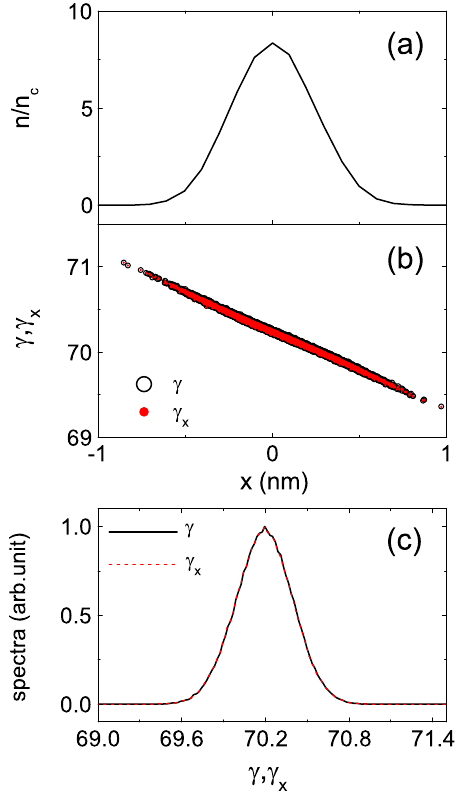
FIG. 2. PIC results for a laser-driven RES obtained for the configuration of Fig. 1: (a) electron density profile; (b) (cid:1) and (cid:1) x plotted versus propagation direction x ; (c) electron energy spec- trum. The results correspond to Fig. 1(c), i.e., to the time when the RES has just emerged from the reflector foil. Simulation parameters are given in Sec. II A.